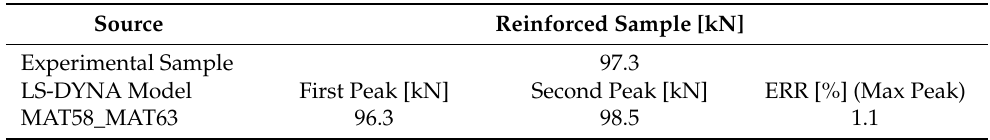
Figure 9. The characteristic force-displacement curve for the simple composite joint. Table 8. Reinforced maximum load